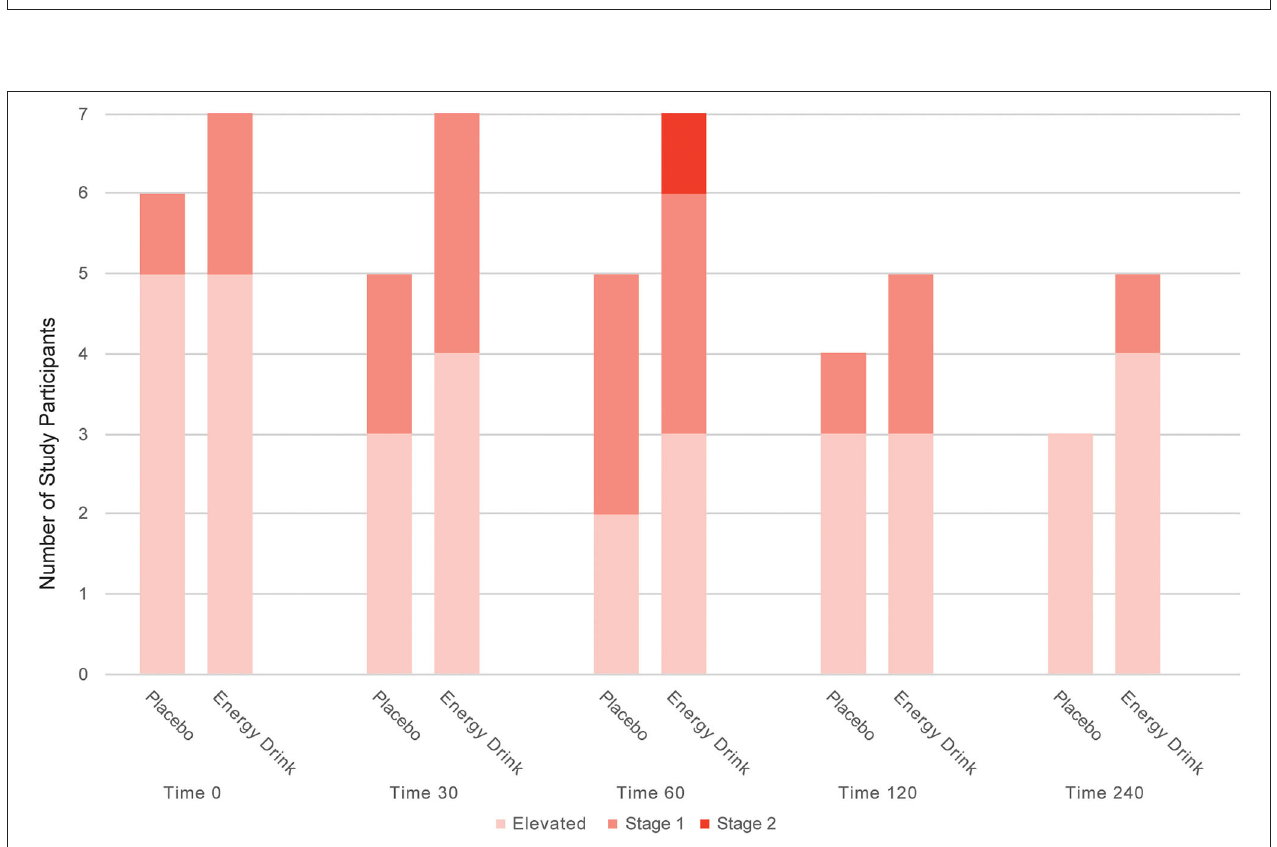
FIGURE 2 | Number of study participants with elevated systolic blood pressure, stage 1 and stage 2 systolic hypertension after Energy Drink and placebo consumption at different time points.